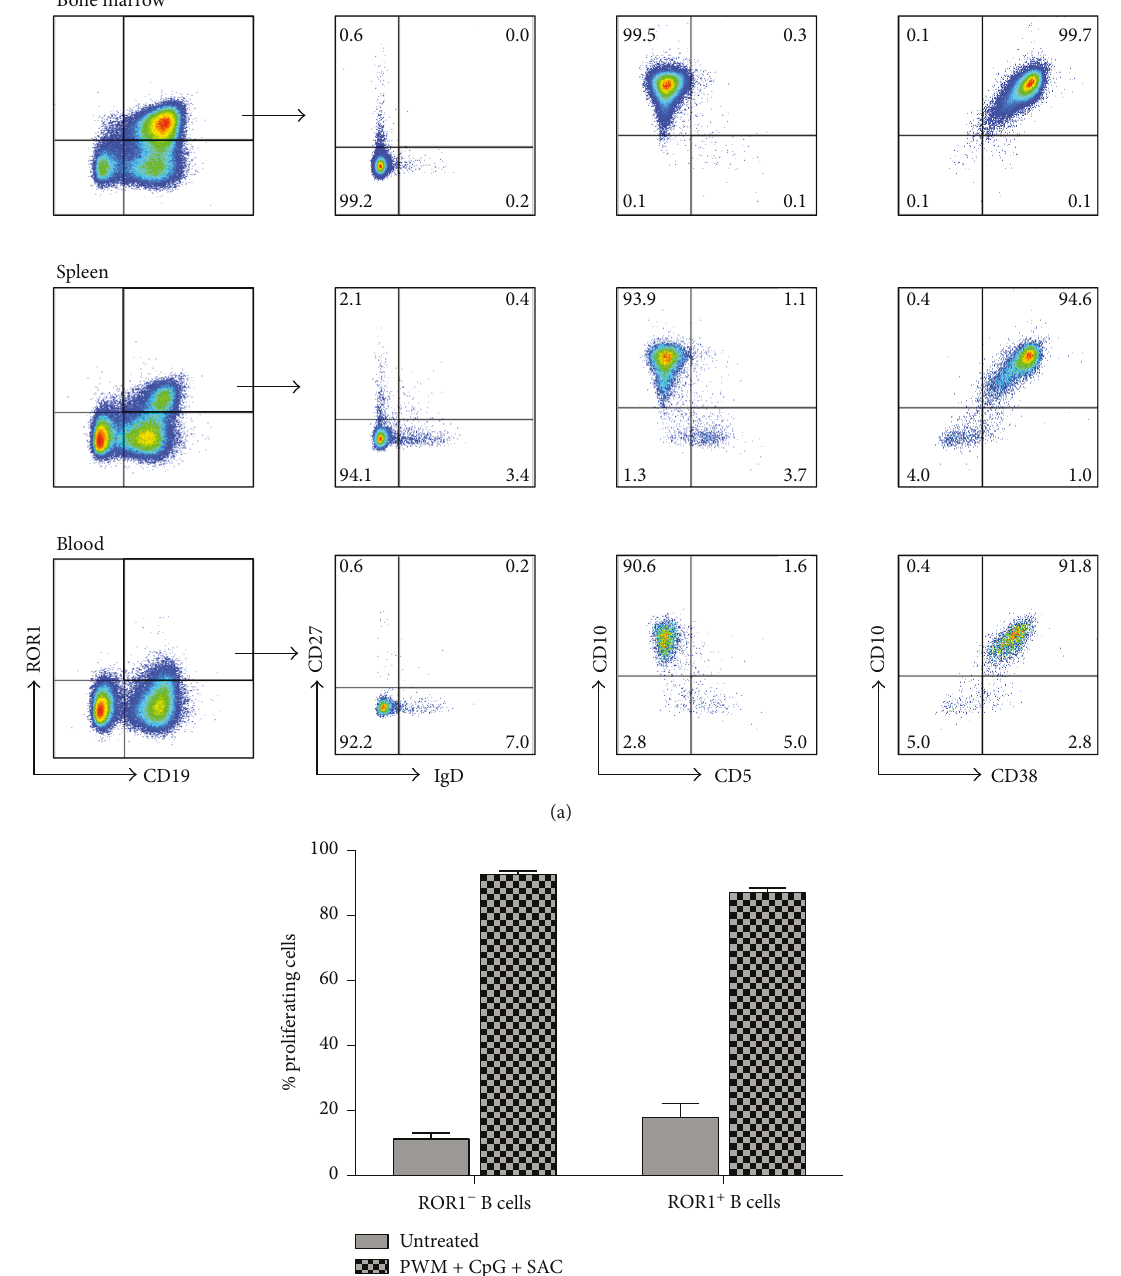
Figure 4: ROR1-expressing B cells were mostly immature B cells. (a) Flow cytometry staining of cells from the bone marrow, spleen, and blood of huNSG mice. Cells from the left panel were pregated as live cells, singlet cells positive for human CD45. ROR1 + CD19 + cells were further analyzed for their expression of CD27, IgD, CD10, CD5, and CD38. Representative data from 3 di ff erent cohorts of huNSG mice are shown. (b) Splenocytes from huNSG mice were stained with CellTrace Violet and stimulated with PWM, CpG, and SAC or left unstimulated. After 4 days, cells were harvested and stained with CD19 and ROR1 antibodies, and percentage of proliferation of live gated CD19 B cells was measured by dye dilution by fl ow cytometry. The % of proliferating ROR1 + and ROR1 − B cells is shown. The graph depicts the results from 2